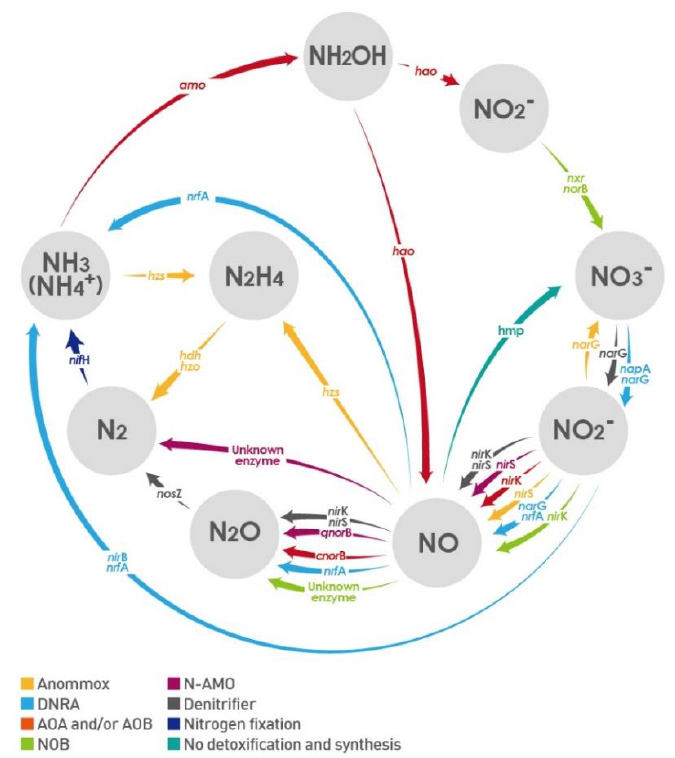
Figure 1. The nitrogen cycle and related functional microorganism genes.